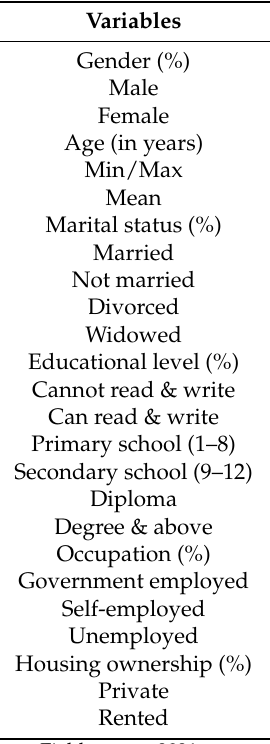
Table 1. Socio-demographic characteristics of respondents ( n = 65 for each